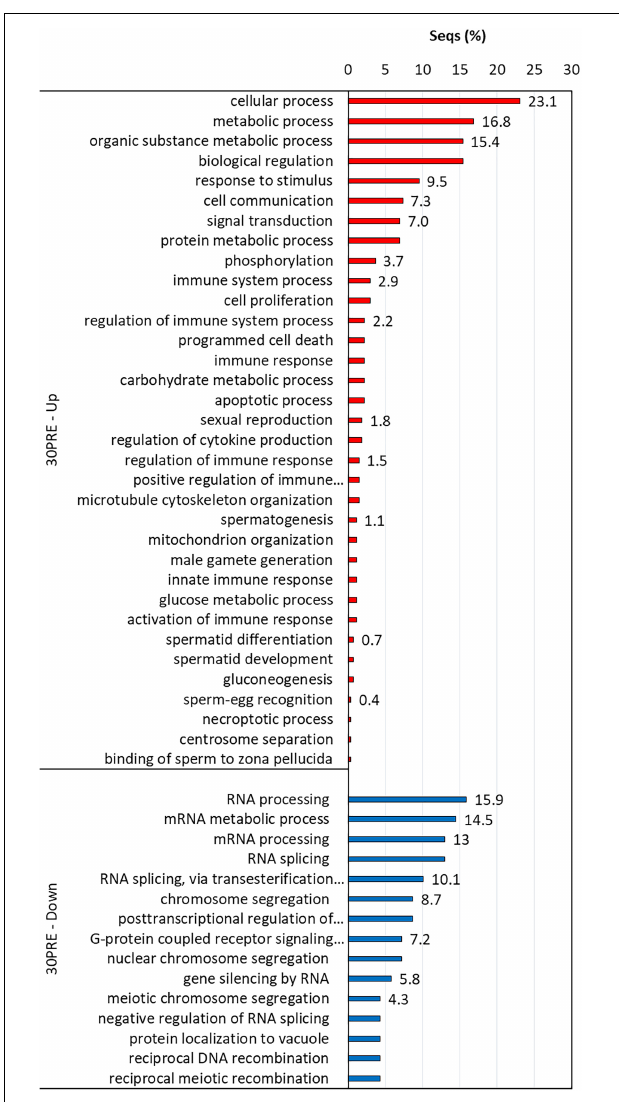
FIGURE 6 | Enriched GO terms of biological processes (Fisher exact test, FDR < 0.05) in 30PRE treatment vs. the control treatment (24PRE). Up (red) and down-regulated (blue) transcripts are shown.